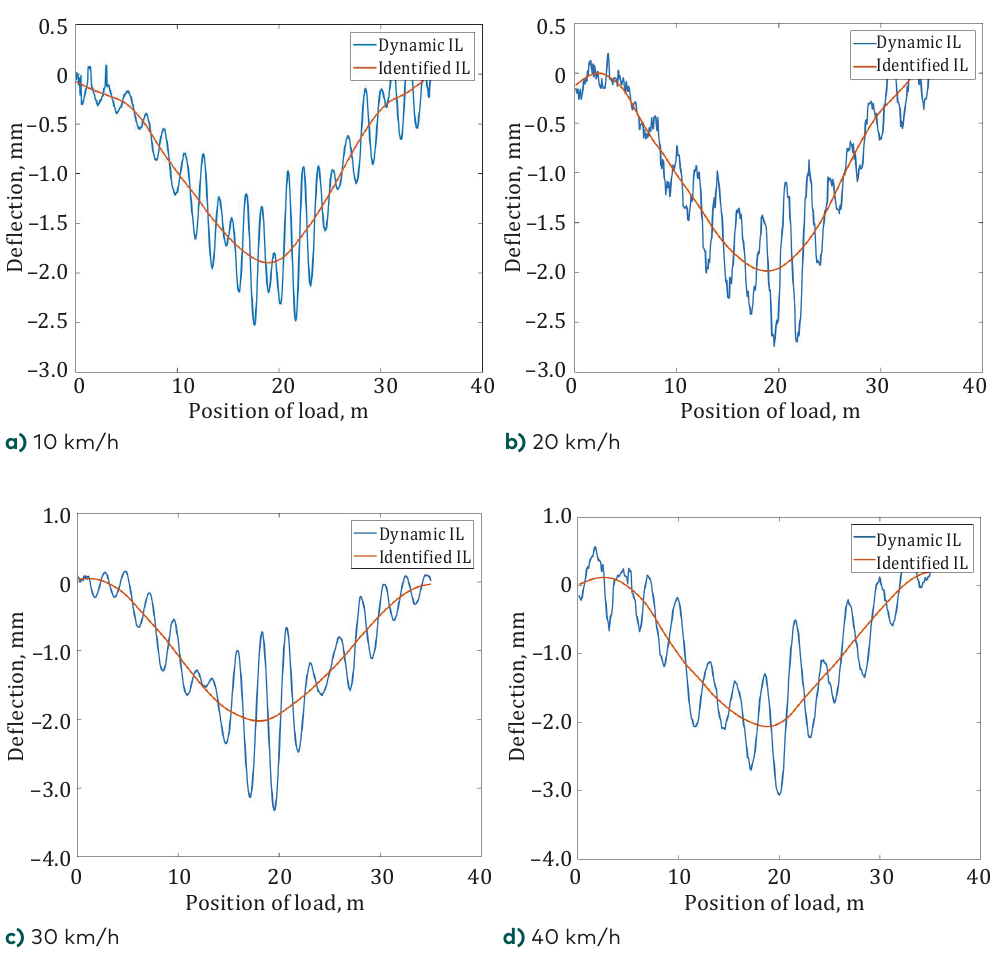
Figure 7. Identified results of the EMD